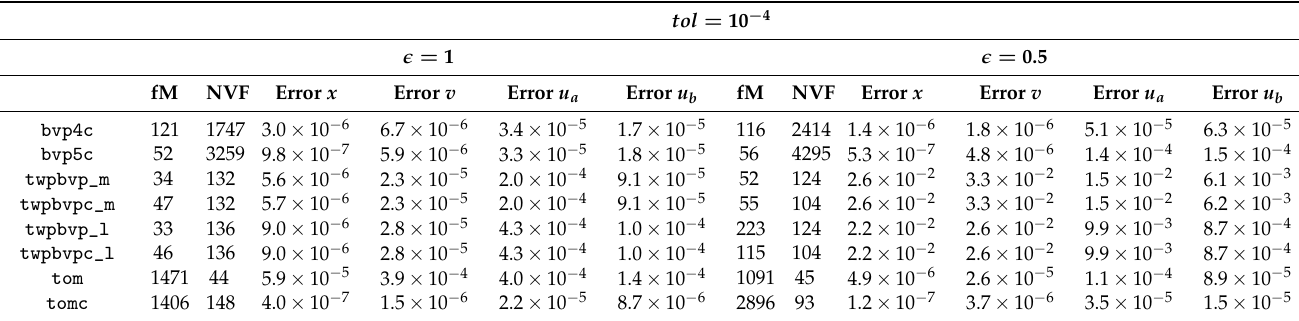
Table 21. Minimization of the fuel cost in the operation of a train (18) using a piecewise quadratic penalty function with τ = 10 − 2 : final mesh (fM), total number of vectorized function evaluation (NVF) and mixed errors for x , v , u a , u b